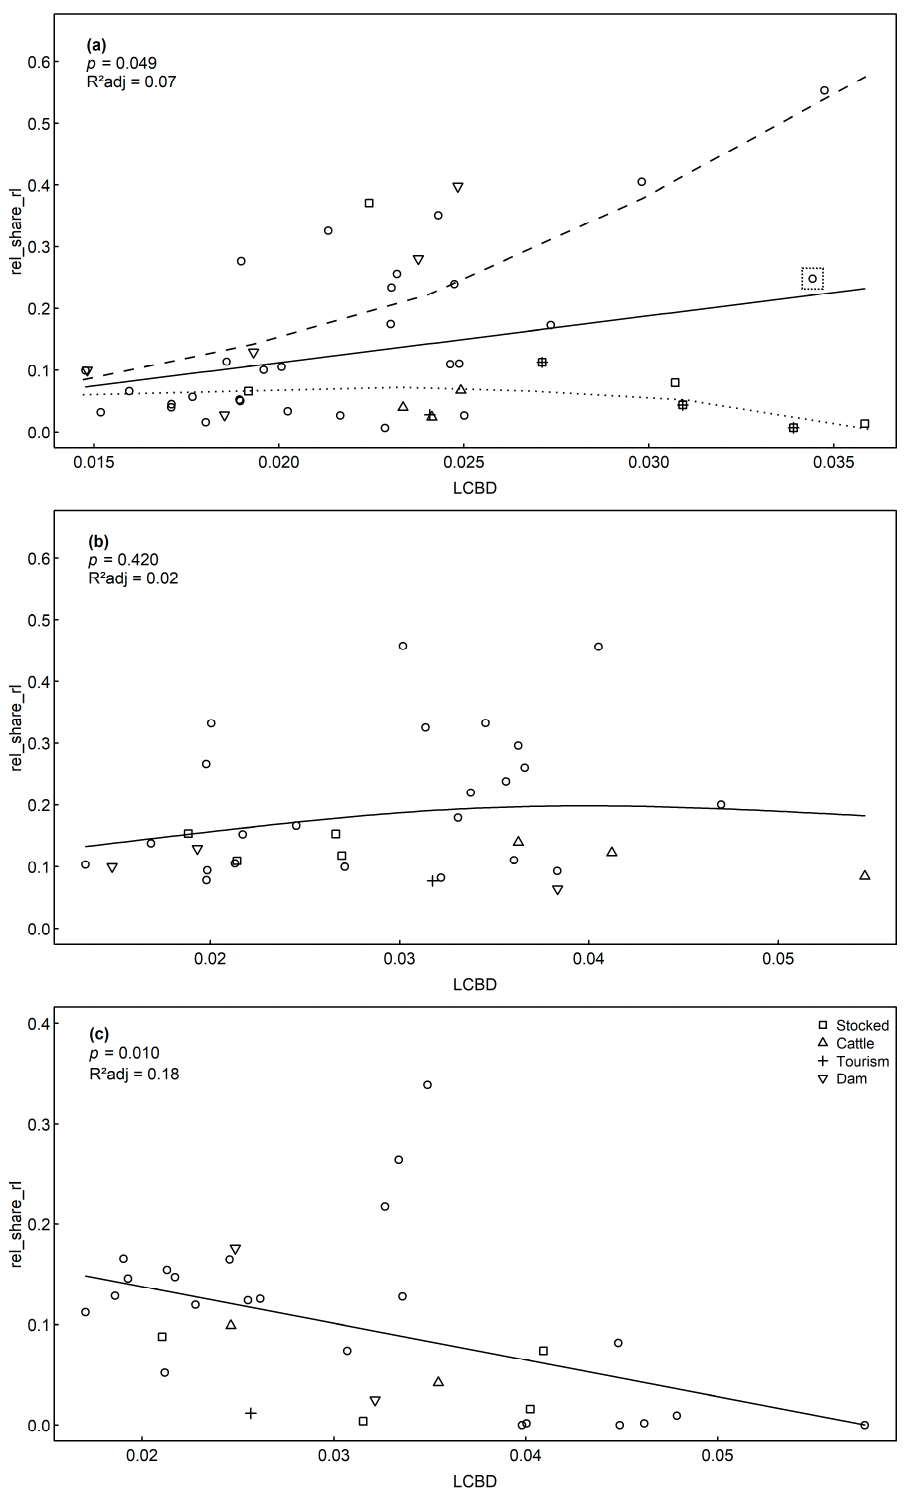
5 Figure 6. The abundance share of RL species (rel_share_rl) increases with higher uniqueness (repre- sented by the local contribution to β diversity, LCBD) for sedimentary ( a ) and decreases for planktic assemblages ( c ), while no significant trend was found for littoral assemblages ( b ). The assumed trend for unimpaired and impaired lakes is indicated by a dashed and dotted line respectively for the sedimentary dataset. The dotted box indicates one outlier lake with a strong influence of groundwater (SieG, Table